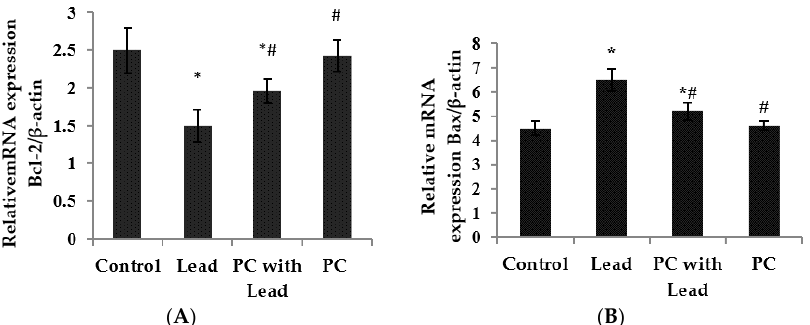
Figure 3. The effect of proanthocyanidin (PCs) on the mRNA levels of Bcl ‐ 2 and Bax in the liver of mice exposed to lead. ( A ) Bcl ‐ 2 ; ( B ) Bax . All results are expressed as the mean ± SE ( n = 7). * p < 0.05, significant change with respect to the control; # p < 0.05, significant change with respect to lead ‐ treated mice.